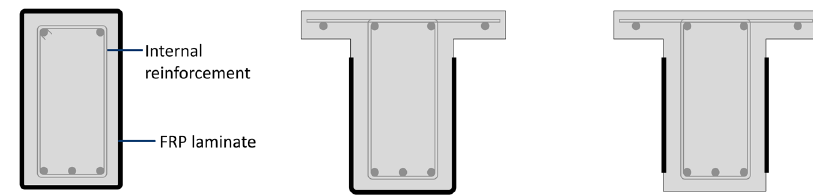
Figure 4. Different FRP wrapping schemes.